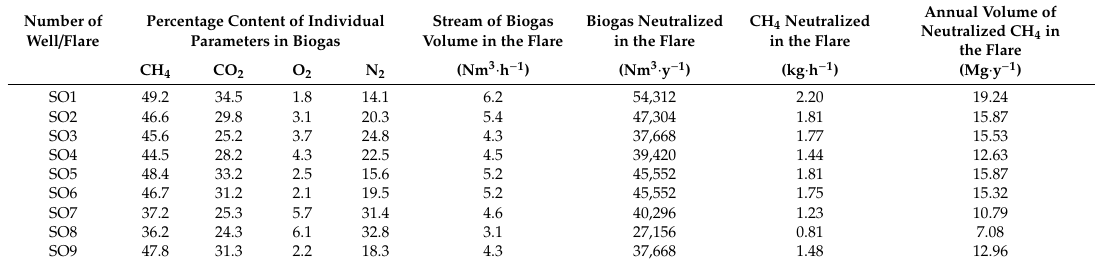
Table 2. Parameters of landfill biogas in gas flares.